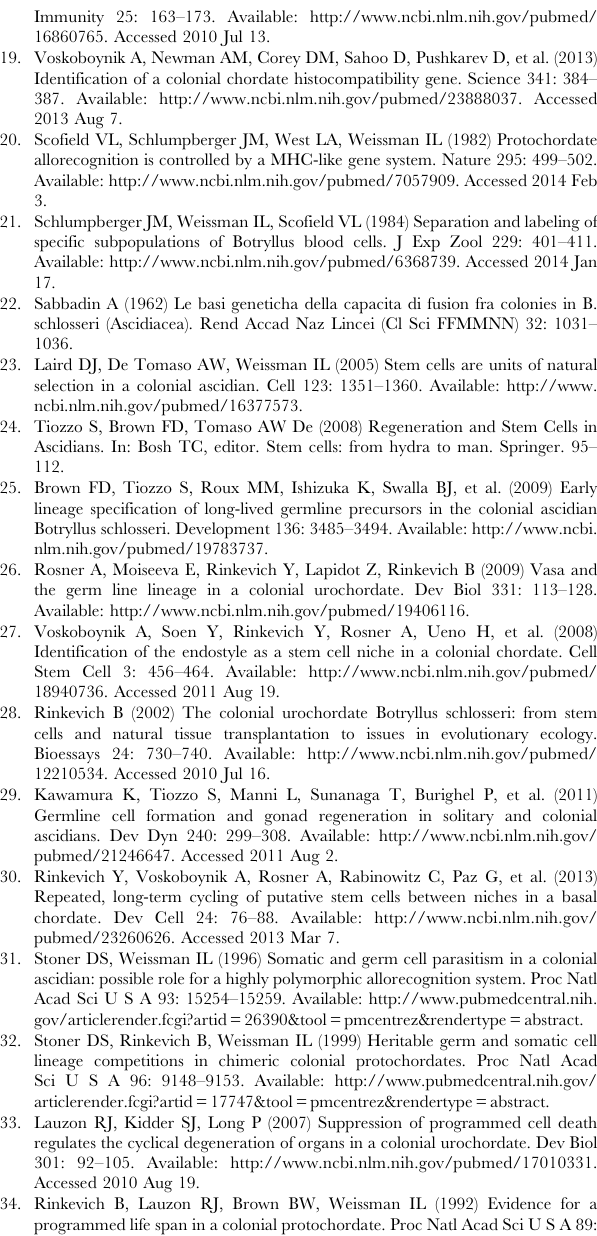
Figure S1 Botryllus schlosseri staging flowchart for asexual development. Flowchart for asexual development of B. schlosseri that help to individuate in vivo , under a dissection microscope, the stage of the colony, and permit also to easily compare the staging methods by Sabbadin [6] and Lauzon